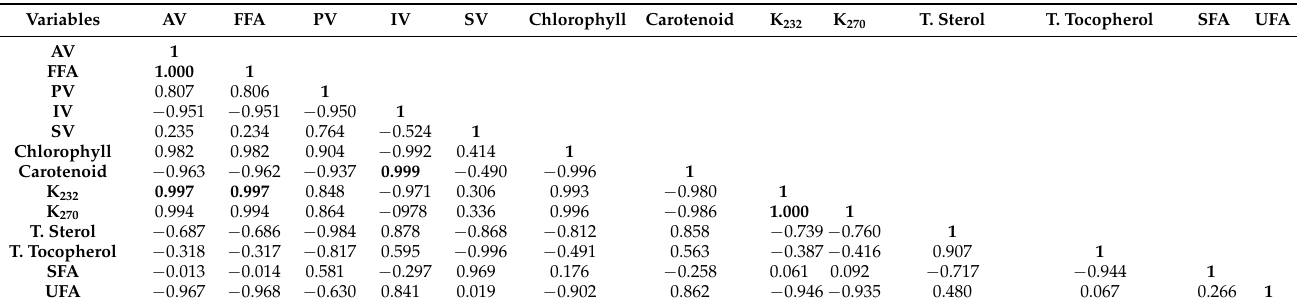
Table 6. Pearson’s correlation matrix coefficient between physicochemical characteristics and chemi- cal